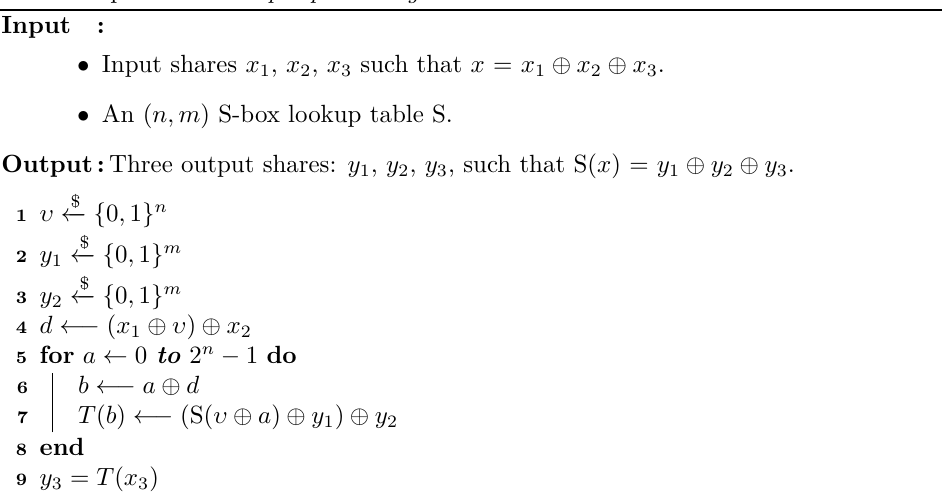
Algorithm 1: Variant of [RDP08, Algorithm 2]: second-order secure masked S-box computation with pre-processing